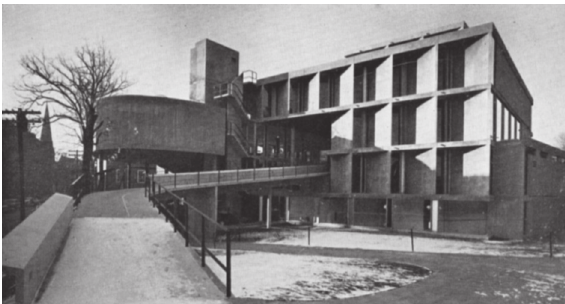
fig. 12. location plan and view of the Carpenter Center for the Visual arts (le Corbusier 1965: 61)